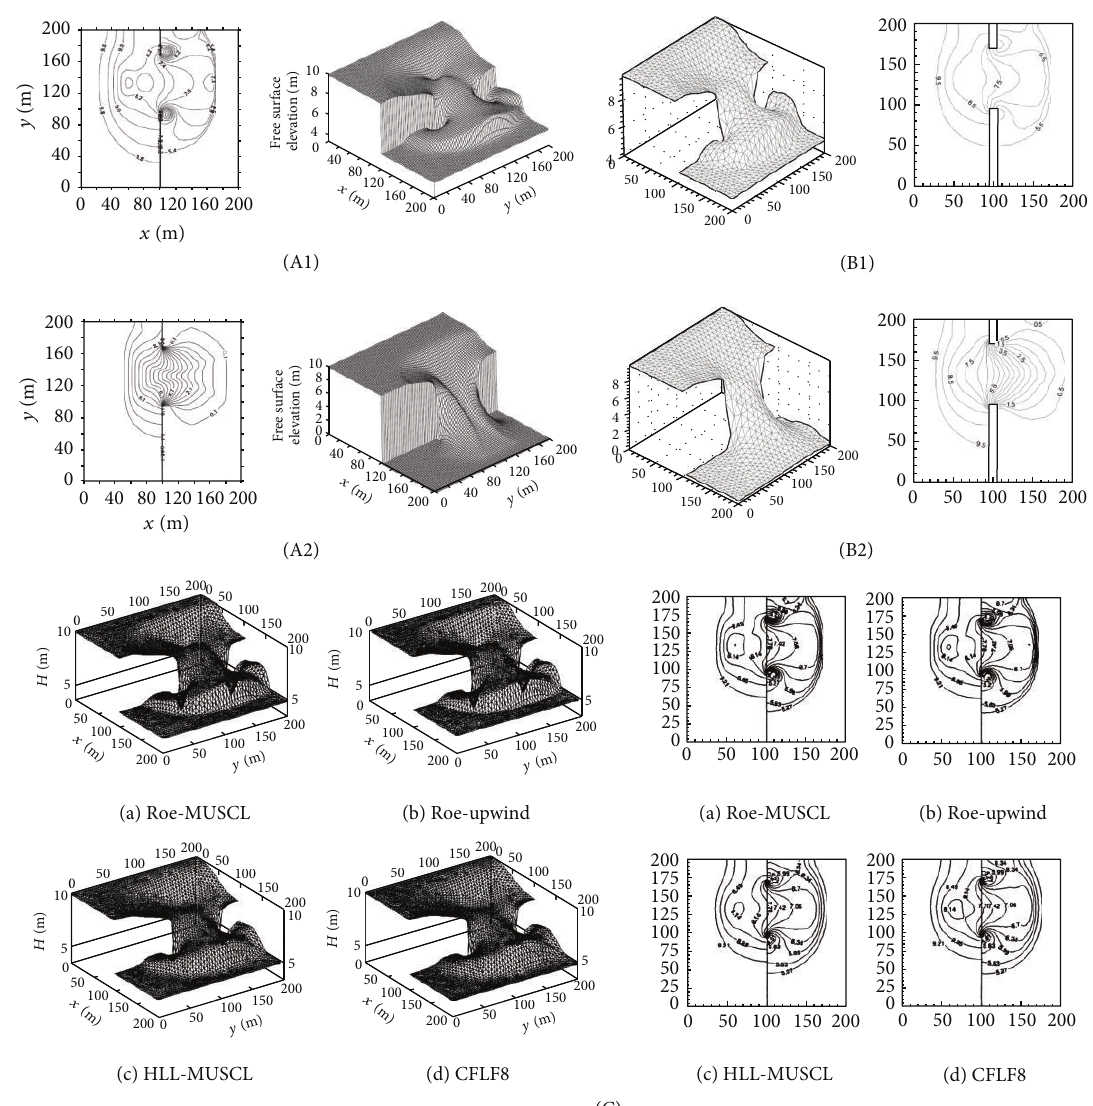
Figure 7: 2D asymmetrical partial dam break test in a frictionless, horizontal, and wet/dry bed domain at 𝑡 = 7.2 s by some other researchers. (A1) Liang et al.; Wet bed [11], (A2) Liang et al.; dry bed at 𝑡 = 5 s [11], (B1) Loukili and Soula¨ımani-Wet Bed [14], (B2) Loukili and Soula¨ımani- Dry Bed [14], and (C) Wang and Liu